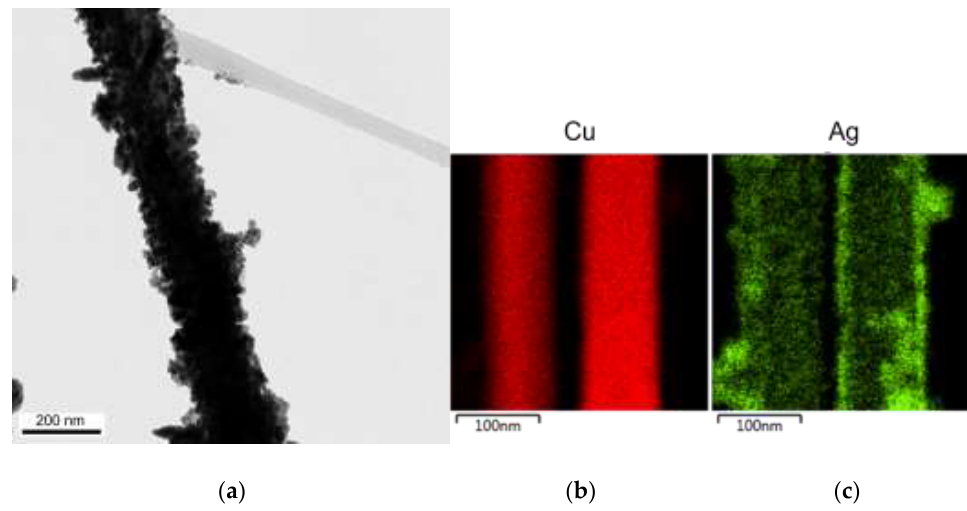
Figure 18. ( a ) TEM image of Cu-Ag nanowires; EDX mapping element ( b ) Cu; ( c ) Ag.